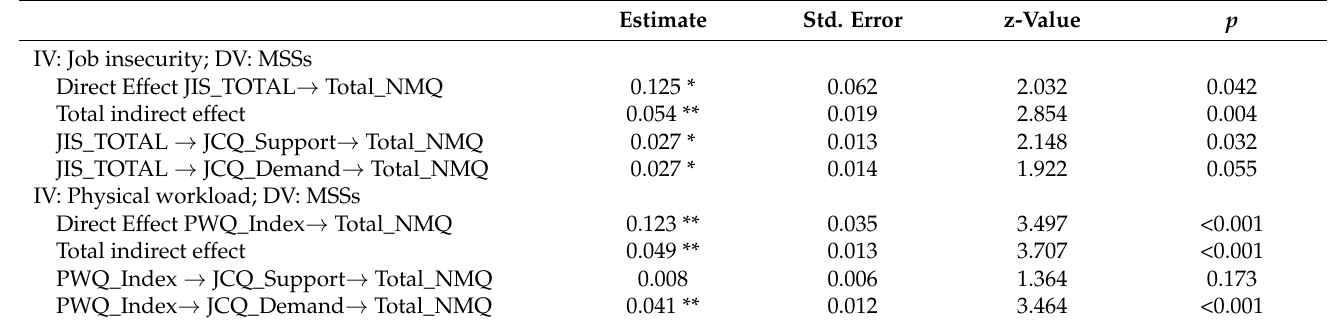
Table 5. Direct effects, total indirect effects, and indirect effects of parallel mediation with path analysis